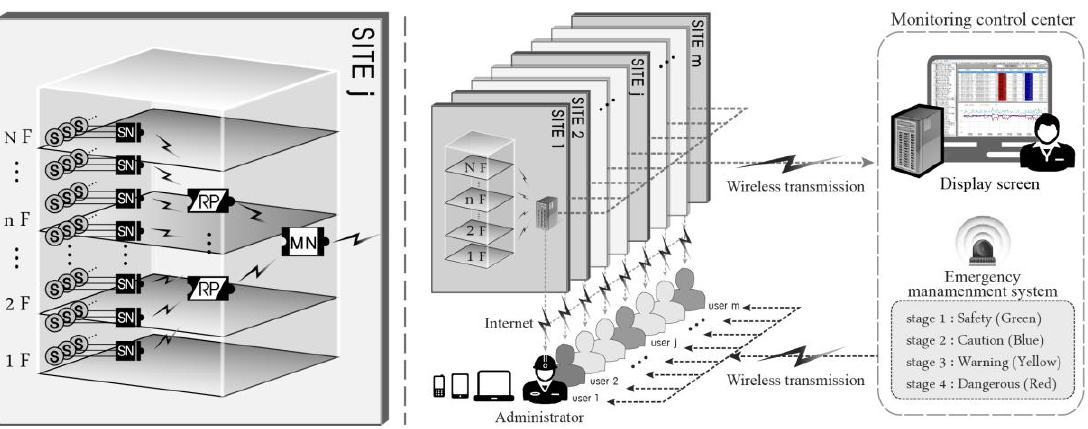
Figure 2. Site zoning of an SHM system (F: